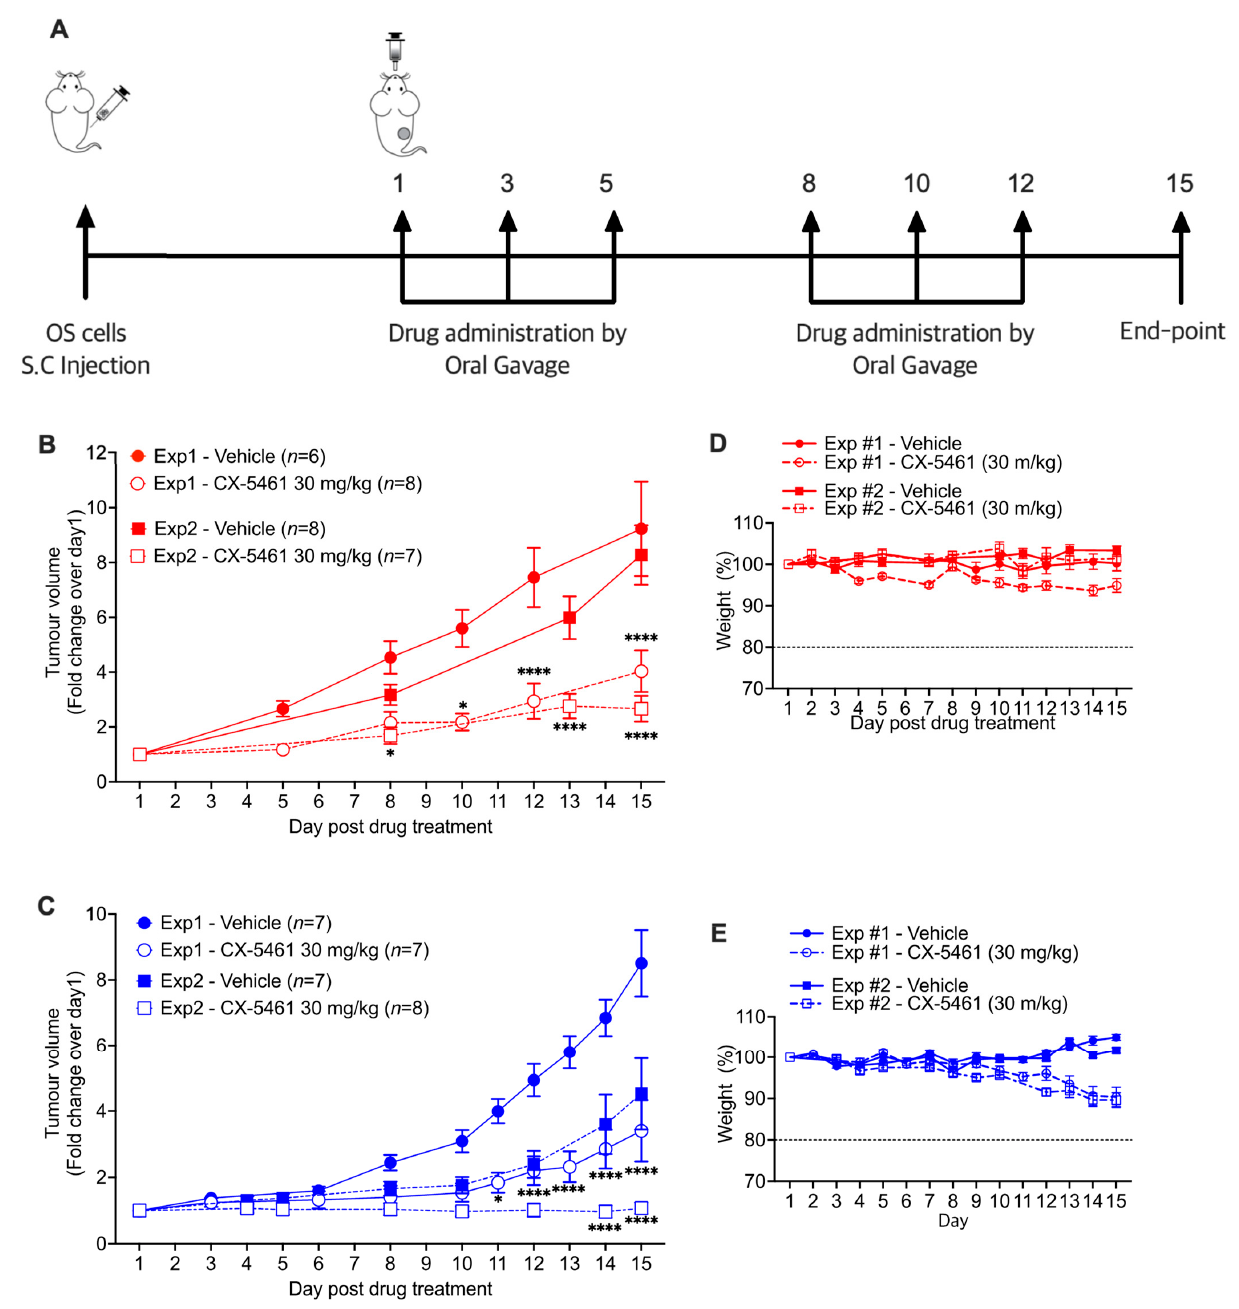
Figure 4. CX-5461 reduces tumour growth in human OS xenograft mouse models. ( A ) Schematic of human OS xenograft mouse model: OS cells were injected subcutaneously into the right flanks of male and female Rag2 KO mice; then, when tumours could be measured using digital callipers, mice were randomised (ensuring equal distribution of sex and tumour size) to vehicle (50 mM NaH 2 PO 4 (pH4.5)) or CX-5461 (30 mg/kg) group thrice weekly for two weeks. ( B ) 143B-Luc OS cells (abnormal p53; 1 × 10 6 cells in 50 µL of HBSS) or ( C ) SJSA-1-Luc OS cells (normal p53; 3 × 10 6 in 50 µL of HBSS containing 50% Matrigel) were injected. Tumour volume was monitored and expressed in each mouse as the fold change in the tumour size at the start of treatment, with the average of each treatment group depicted. ( D , E ) The weight of each mouse was monitored during the treatment period, with a 20% reduction in body weight being the ethical end point (dotted line), which was not reached. Mean +/ − SEM of biological replicates as indicated. Statistical analysis was performed using two-way ANOVA, * p < 0.05, **** p < 0.0001.